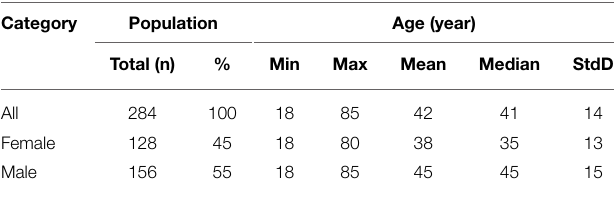
TABLE 4 | Age wise gender based demographic statistics of the respondents.